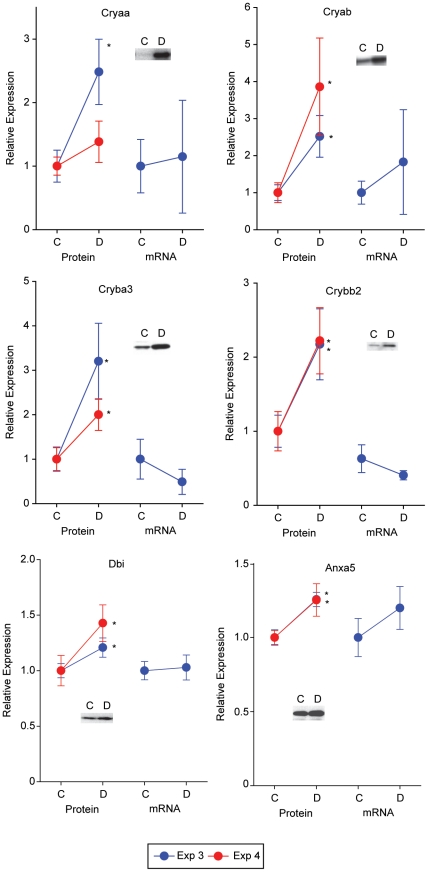
Confirmation of discovery findings in independent animal sets.Targets identified in the proteomic and transcriptomic analyses were confirmed at the level of protein expression by immunoblotting in two independent animal sets (Experiments 3 & 4). mRNA expression was also examined in samples from Experiment 3 by qPCR. Elevated levels of retinal crystallin, alpha B (Cryab); crystallin, beta A3 (Cryba3), crystallin, beta B2 (Crybb2), diazepam-binding inhibitor (Dbi), and annexin 5 (Anxa5) protein were confirmed in two independent animal sets. Crystallin, alpha A (Cryaa) was significantly elevated in one set of animals but did not reach significance in the other. For these six proteins there was no concomitant change in mRNA expression. C = Control, D = Diabetic, * p<0.05, two-tailed t-test.